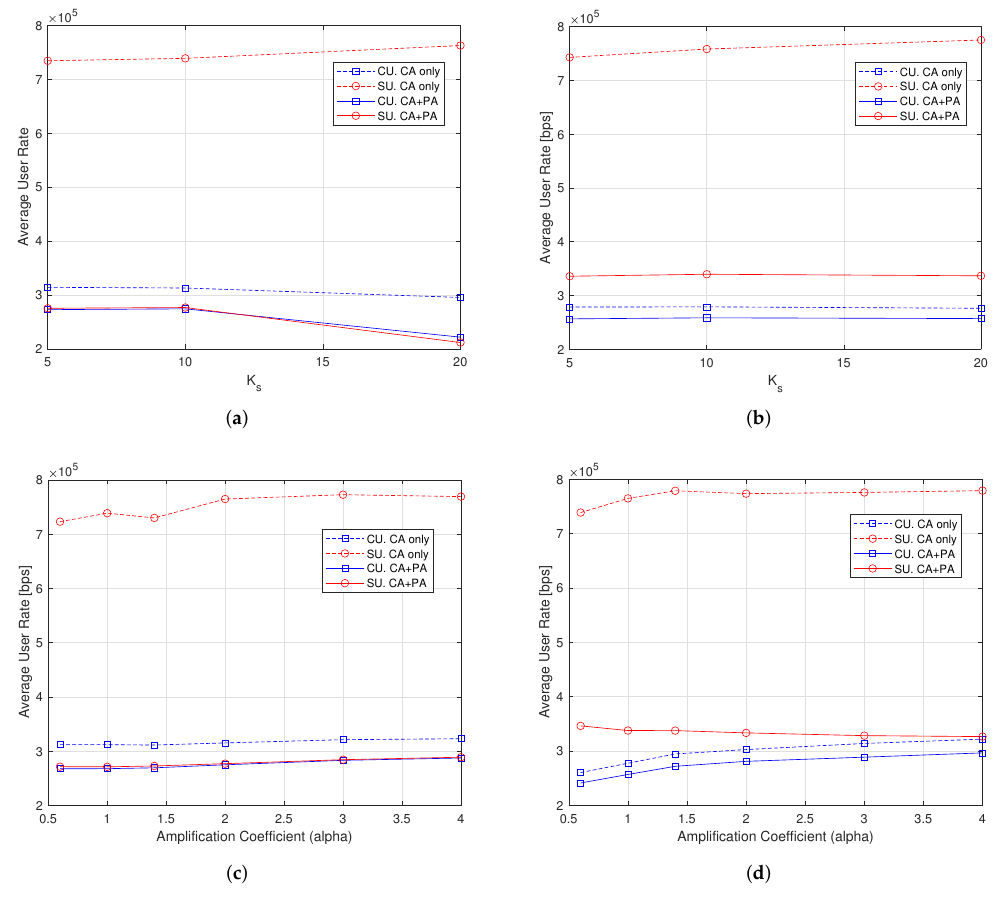
Figure 5. Average user rate with F = 1, K c = 30 users, 100 iterations. ( a ) Varying K s , α = 1, CE- aware; ( b ) varying K s , α = 1, CE-unaware; ( c ) varying α , K s = 10, CE-aware; ( d ) varying α , K s = 10,